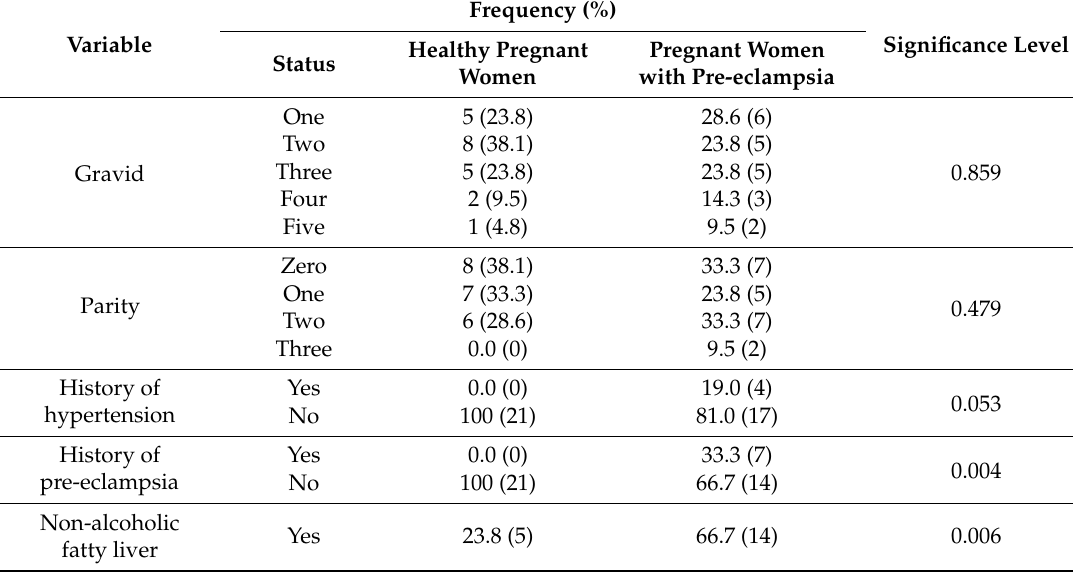
Table 4. Basic characteristics of pregnant women and pregnant women with pre-eclampsia based on the frequency.